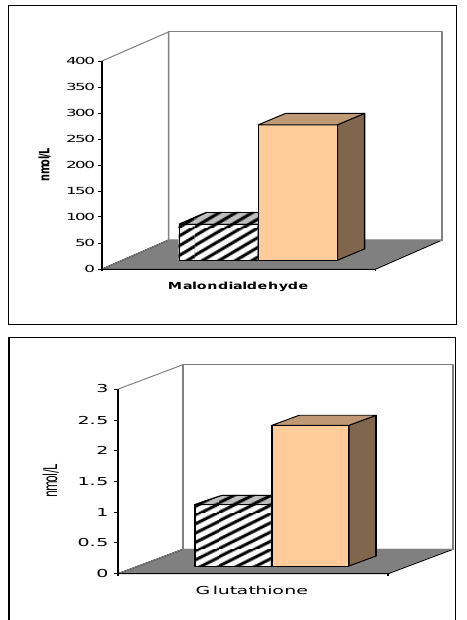
Figure 2: Mean (±SE) Malondialdehyde and Glutathione concentration in serum of patients with Brucellosis disease (n=20) and control groups (n=15) the differences are significant P< 0.005 for glutathione, and p<0.001 for